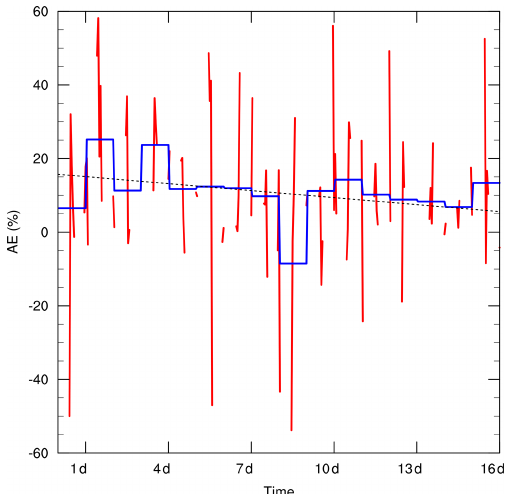
Figure 15. Assimilation efficiencies (AEs) calculated against the Moderate Resolution Imaging Spectroradiometer (MODIS) Aqua- observed AOTs at 550nm for the 4D-LETKF-24H-CALIPSO ex- periment as a function of the distance from the assimilation time. The daily mean time series and the linear regression line are shown as the blue solid and black dashed lines, respectively.